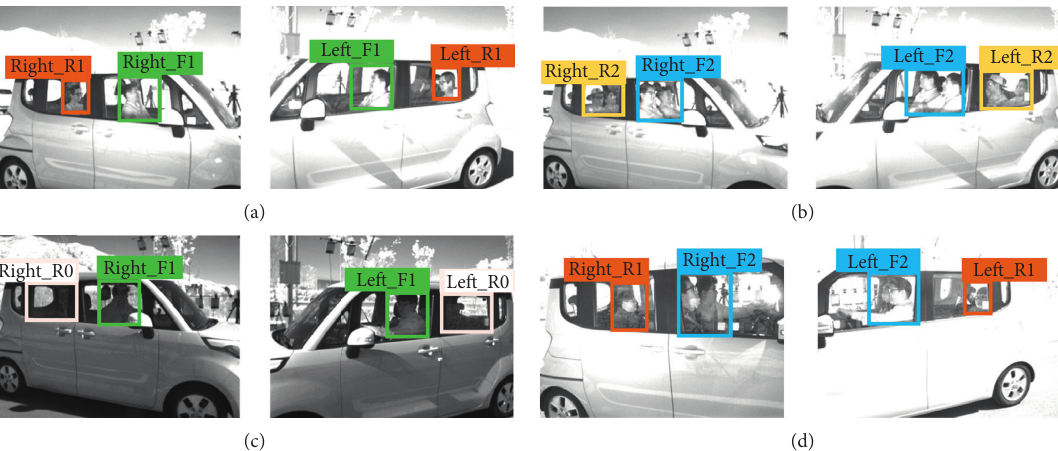
Figure 2: Examples of the new labeling method. (a) Front seat: 1, rear seat: 1 case. (b) Front seat: 2, rear seat: 2 cases. (c) Front seat: 1, rear seat: 0 cases. (d) Front seat: 2, rear seat: 1 case.